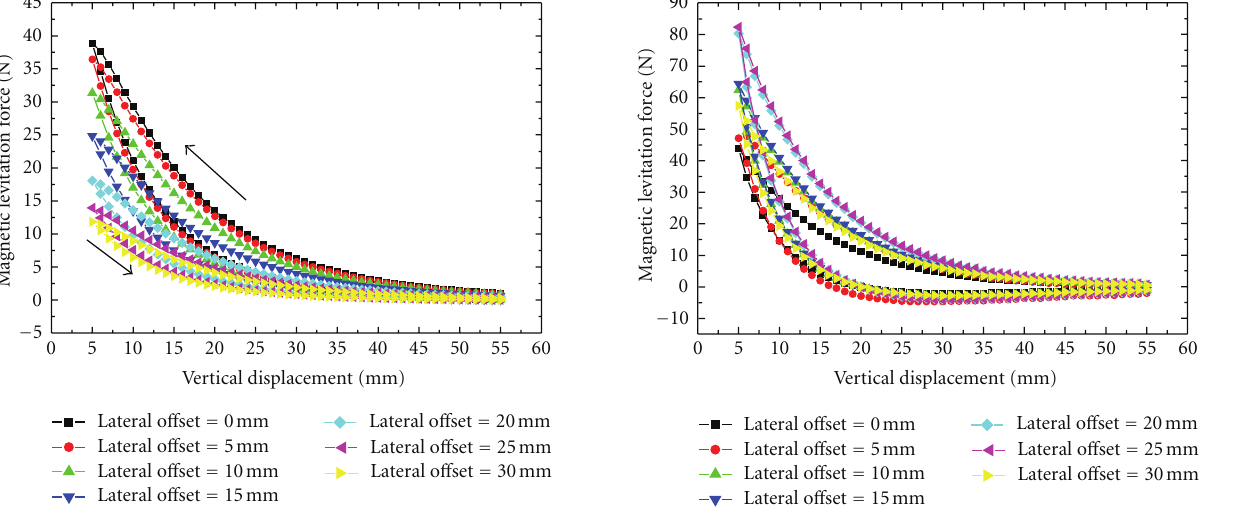
Figure 5: Magnetic levitation force loops of bulk HTS over Halbach PMG with di ff erent lateral o ff